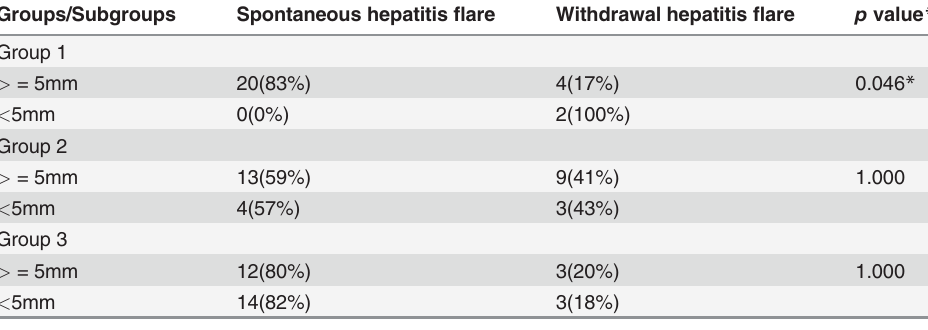
Table 6. The incidence of nodal enlargement (width > = 5mm) in subgroup analysis. Groups/Subgroups Spontaneous hepatitis fl are Withdrawal hepatitis fl are p value